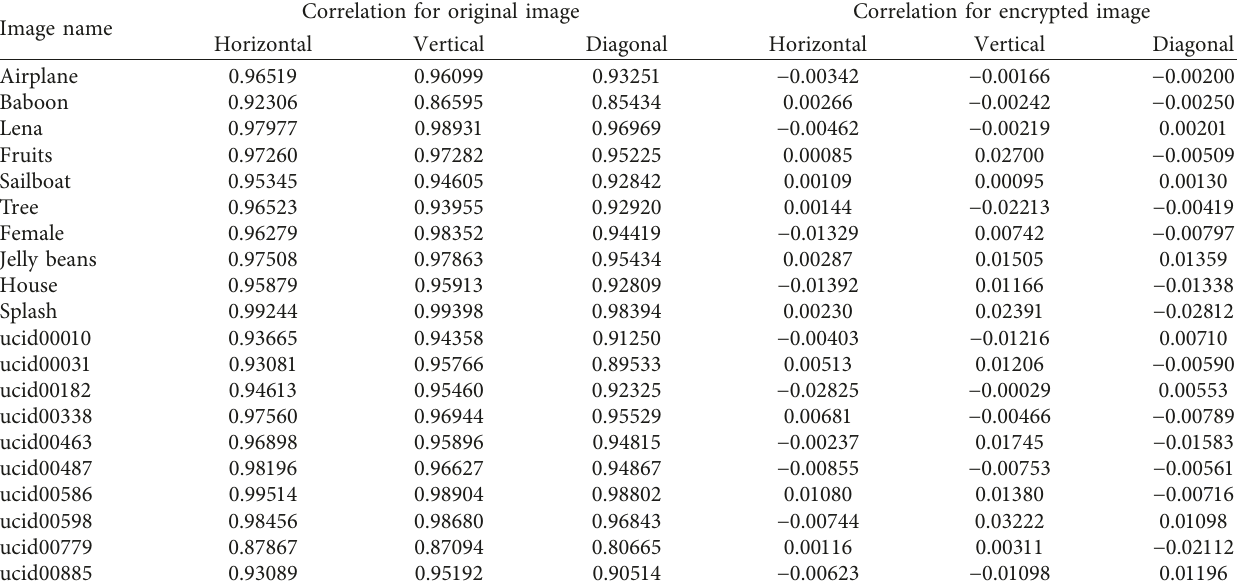
Table 4: Correlation coefficients for original images and encrypted images.